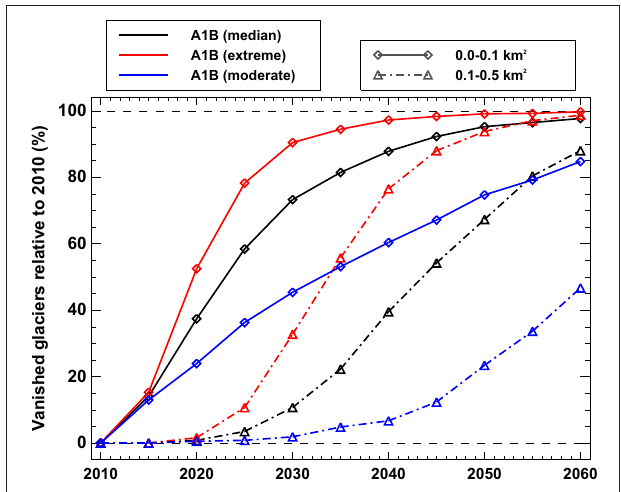
FIGURE 12 | Percentage of glaciers expected to disappear between 2010 and 2060 for the A1B median, extreme, and moderate scenario and two glacier size